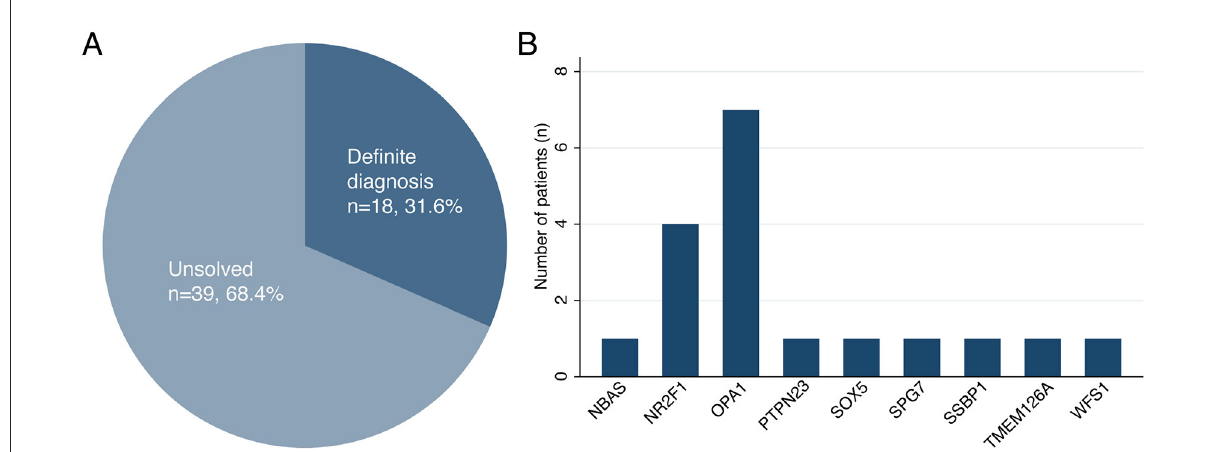
FIGURE1 (A,B) The diagnostic rate of next-generation sequencing and genetic distribution of causative variants with hereditary optic